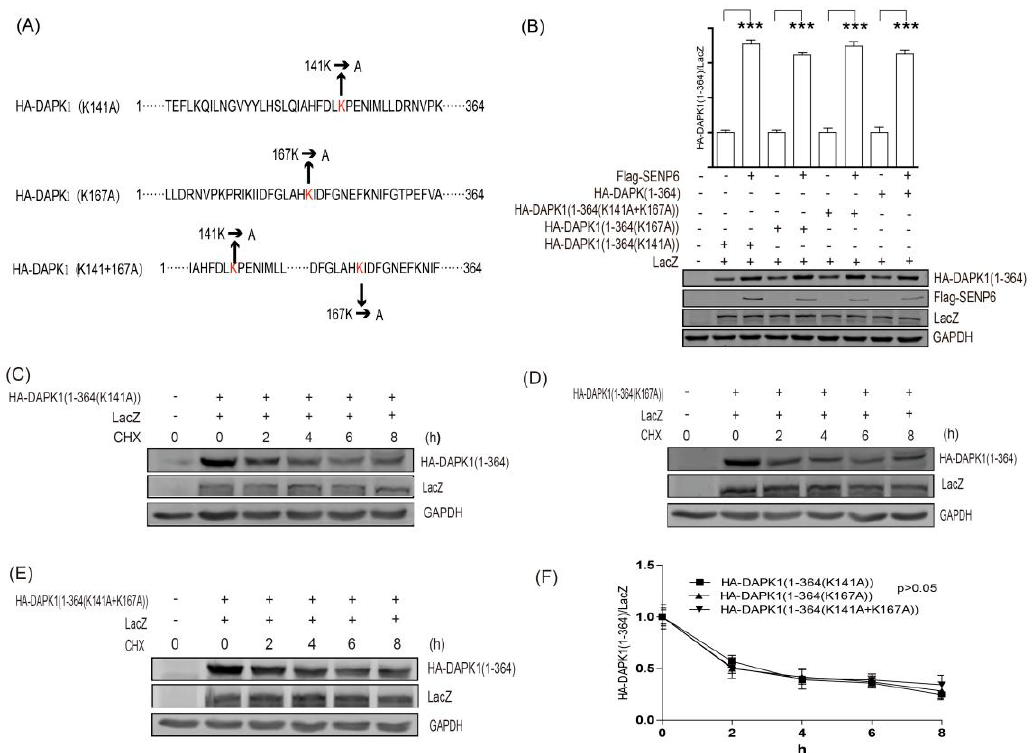
Figure 5. SUMO pathway did not regulate DAPK1 protein levels via direct conjugation. ( A ) A diagram illustrating the panel of DAPK1 (1–364) point mutants. ( B ) HEK293T cells were transfected with LacZ, SENP6 and the DAPK1 point mutants as indicated. ( C – E ) HEK293T transfected with LacZ, DAPK1 (1–364) point mutants were exposed to 20 μ g/mL CHX for 0–8 h as indicated and the statistical results were summarized in ( F ). The intensity of the bands was quantified using LICOR Odyssey software and represented by bar graphs. The experiments were repeated three times (n = 3) and representative images are presented. The representative western blot images are from different gels and each lane was loaded with the same amount of proteins. Data of triplicate assays are presented as mean ± S.D. * p < 0.05; ** p < 0.01; *** p < 0.001; NS, no significance. “+” indicated that the plasmid was transfected, “ − ” indicated that the plasmid was not transfected.